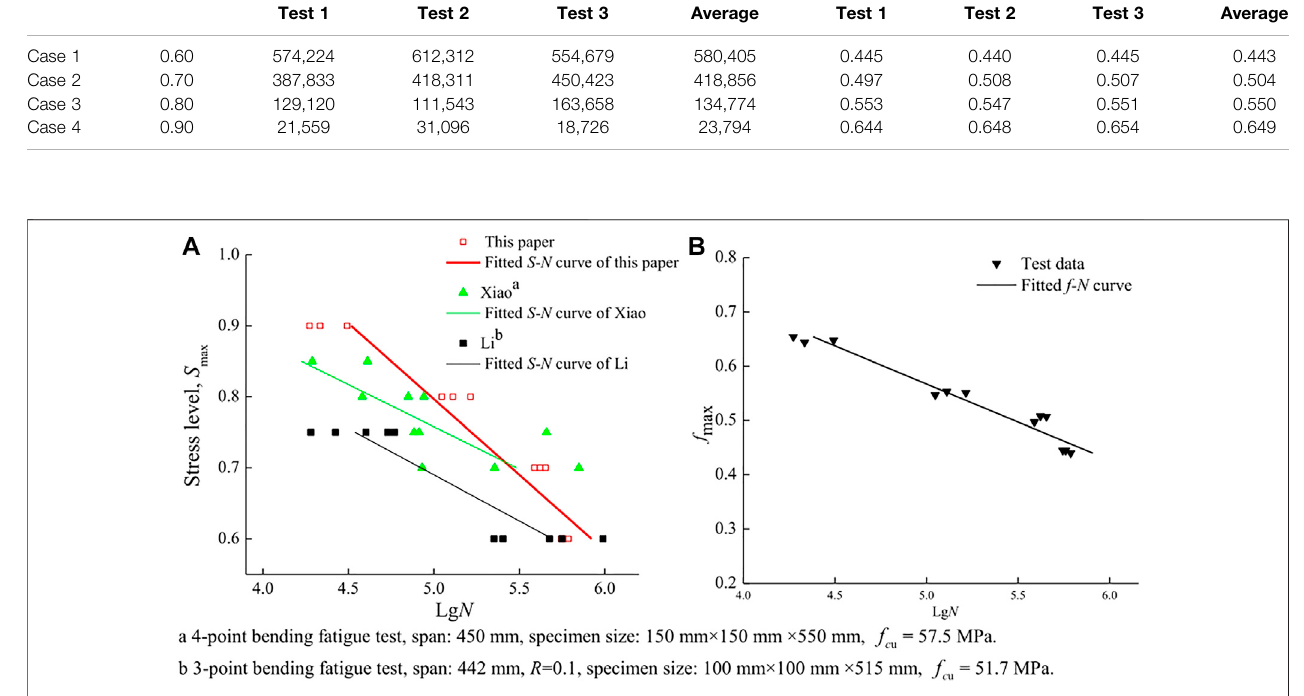
FIGURE 11 | Fatigue life curve. (A) S - N curve; (B) f – N